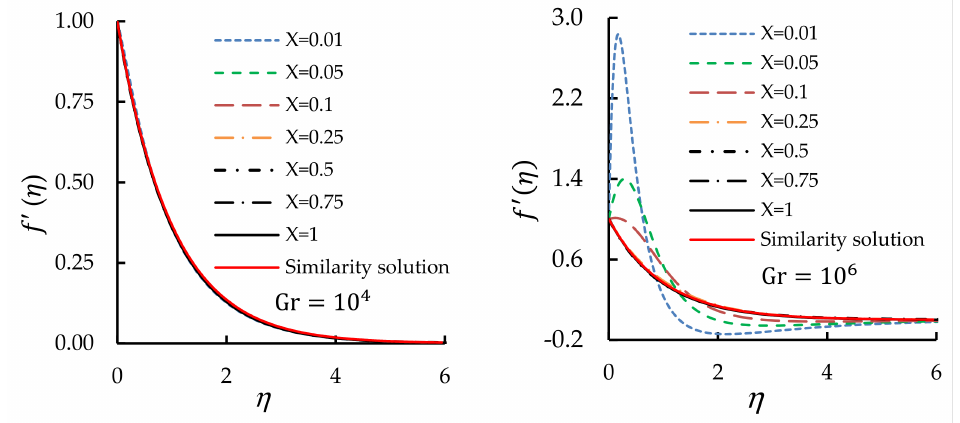
Figure 10. Effect of the Grashof number on the velocity profiles for Re = 400, Pr = 6.2, Le = 10, Nb = Nt = Nr = Rb = Ω = 0.1, and Pe = Lb =